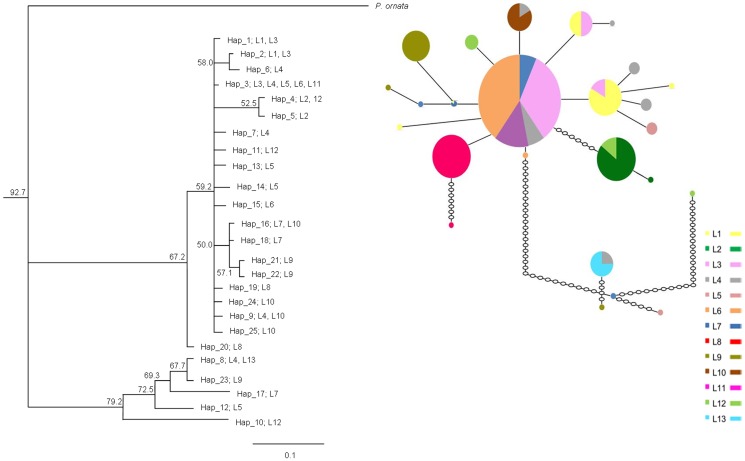
Phylogenetic relationships of mtDNA haplotypes in Phelsuma guimbeaui.The Bayesian tree was produced in MRBAYES with subpopulation identity (L1 to L13) shown at the end of each branch. In the parsimony network, the circles represent different haplotypes, with their size proportional to the number of geckos. Open circles represent predicted but missing or unsampled haplotypes.